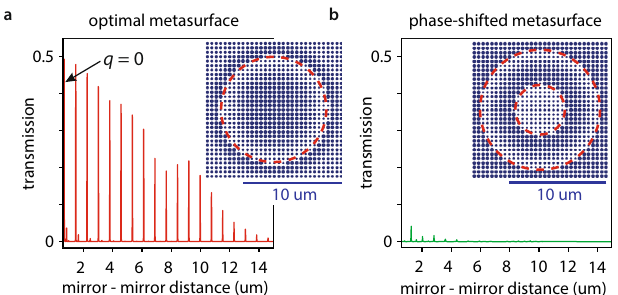
Fig. 2 | Modeling and design of a metasurface-stabilized optical microcavity. a modeled (red solid line) cavity length-dependent transmission of a metasurface- stabilizedmicrocavityusinganoptimalmetasurfacedesign(seeFig.1i).Themodes with low transmission (at shorter than 5um distance) have transverse mode numbers n + m ≥ 1 (see also Supplementary Method 1 and Supplementary Fig. 3). The mode with the smallest longitudinal mode index q =0 is marked with a black arrow.Inset:themetasurfacedesignhasoneboundaryatwhichthepillardiameter changes abruptly (red dashed line). b The same calculation of the cavity length- dependent transmission as in panel ( a ) for a metasurface with a poorly selected phase offset (green line). Inset: the metasurface design has two abrupt changes in the pillar diameters (red dashed lines) of which one is close to the center of the metasurface. Increased scattering at these boundaries reduces transmission through the cavity by